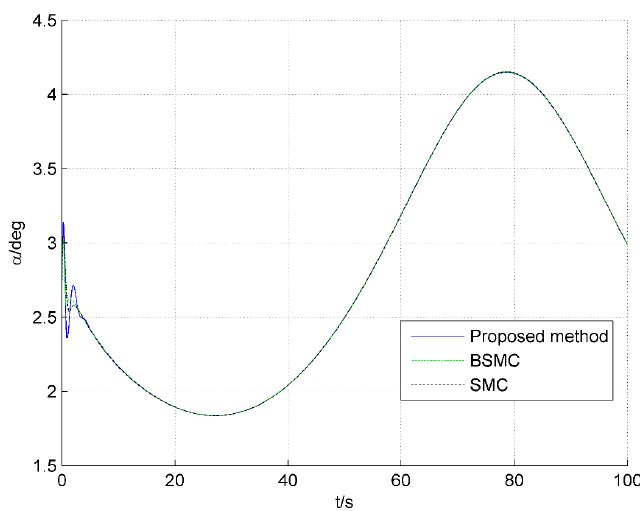
Figure 7. Tracking errors of altitude.